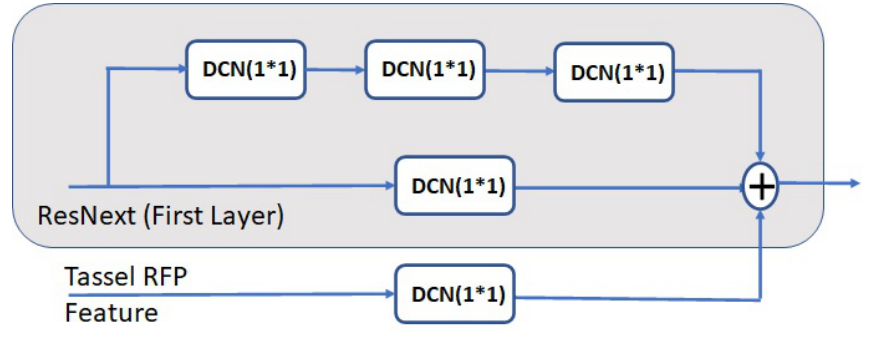
Figure 7. Tassel ASPP.